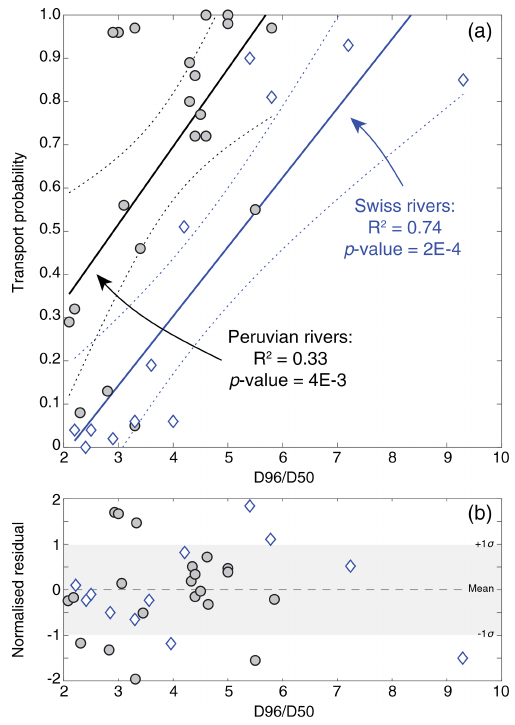
Figure 4. (a) Relationships between the probability of sediment transport occurrence and the D 96 /D 50 ratio, which we use as proxy for the sorting of the gravel bar, in the Swiss and Peruvian rivers. (b) Normalized residuals that are plotted against the sorting. The normalized residuals do not show any specific and significant pat- terns. Blue diamonds correspond to the Swiss rivers, while grey cir- cles are Peruvian